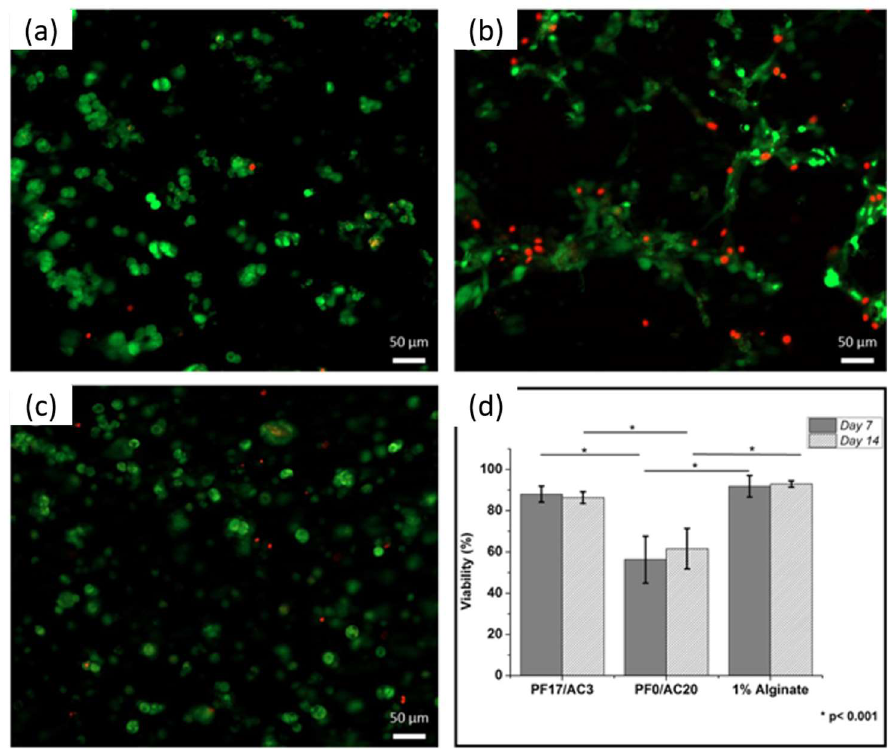
Figure 16. Cell viability of encapsulated bovine chondrocytes at day 14 with live cells in green and dead cells in red. ( a ) Nanostructured PF17/AC3 ( b ) PF0/AC20 and ( c ) 1% alginate. ( d ) Viabilities of encapsulated chondrocytes at day 7 and day 14. Reprinted with permission from [117].